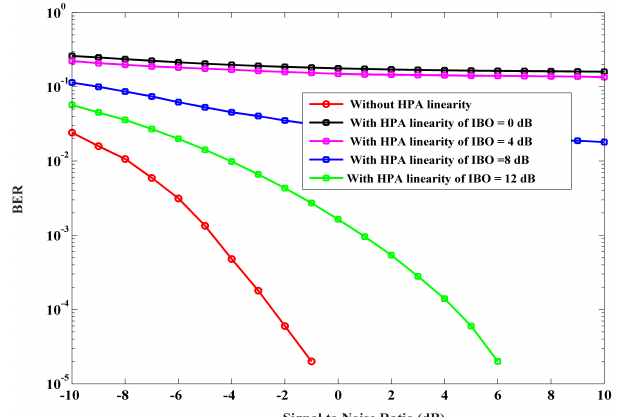
Figure 20. BER performance of the considered system with and without implementation of IBO-based HPA for the case of user 2.